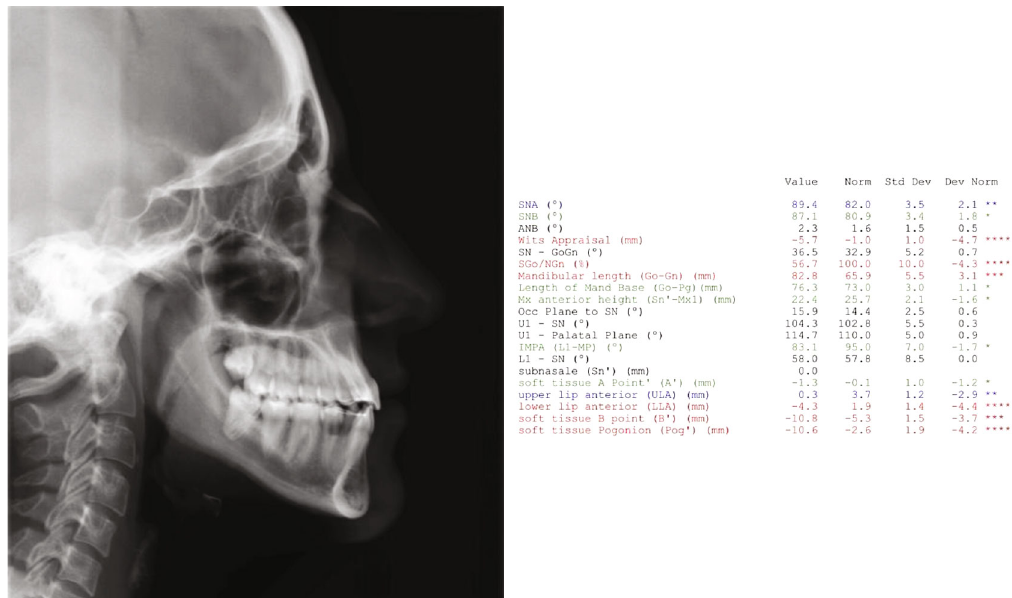
Figure 8: Posttreatment cephalometric analysis.